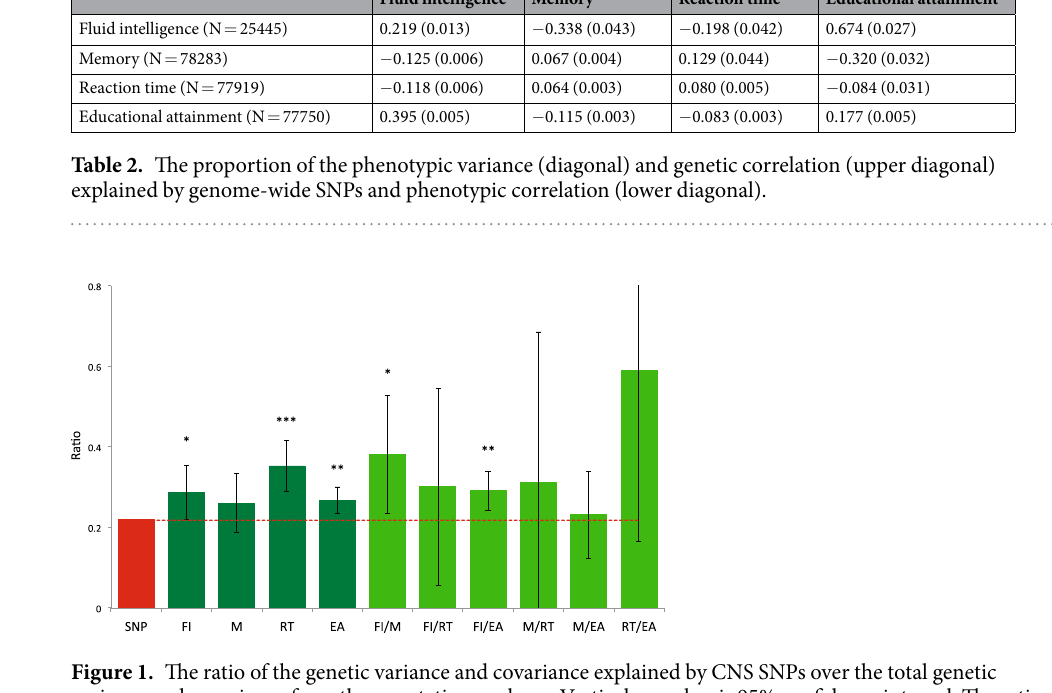
Figure 1. The ratio of the genetic variance and covariance explained by CNS SNPs over the total genetic variance and covariance from the annotation analyses. Vertical error bar is 95% confidence interval. The ratio of SNPs attributed to genes in the CNS is also shown (red). FI: Fluid intelligence. M: Memory RT: Reaction time EA: Educational attainment.